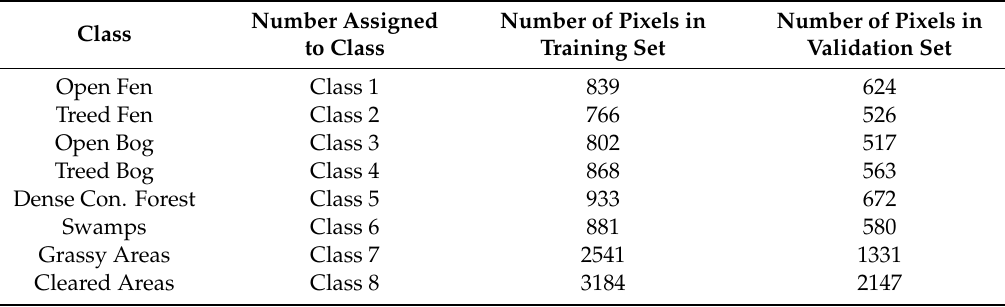
Table 2. Number of pixels used for di ff erent classes in training and